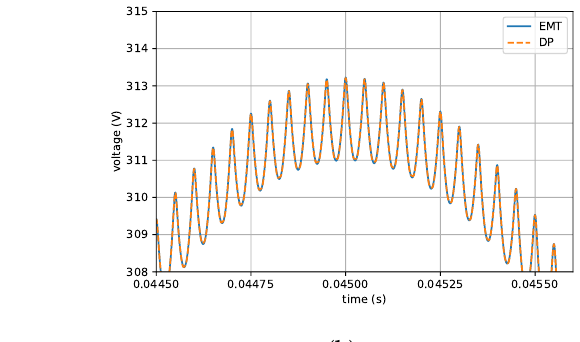
Figure 12. Capacitor voltage of a DP inverter model including the fundamental and eight harmonics compared to a Simulink EMT model.